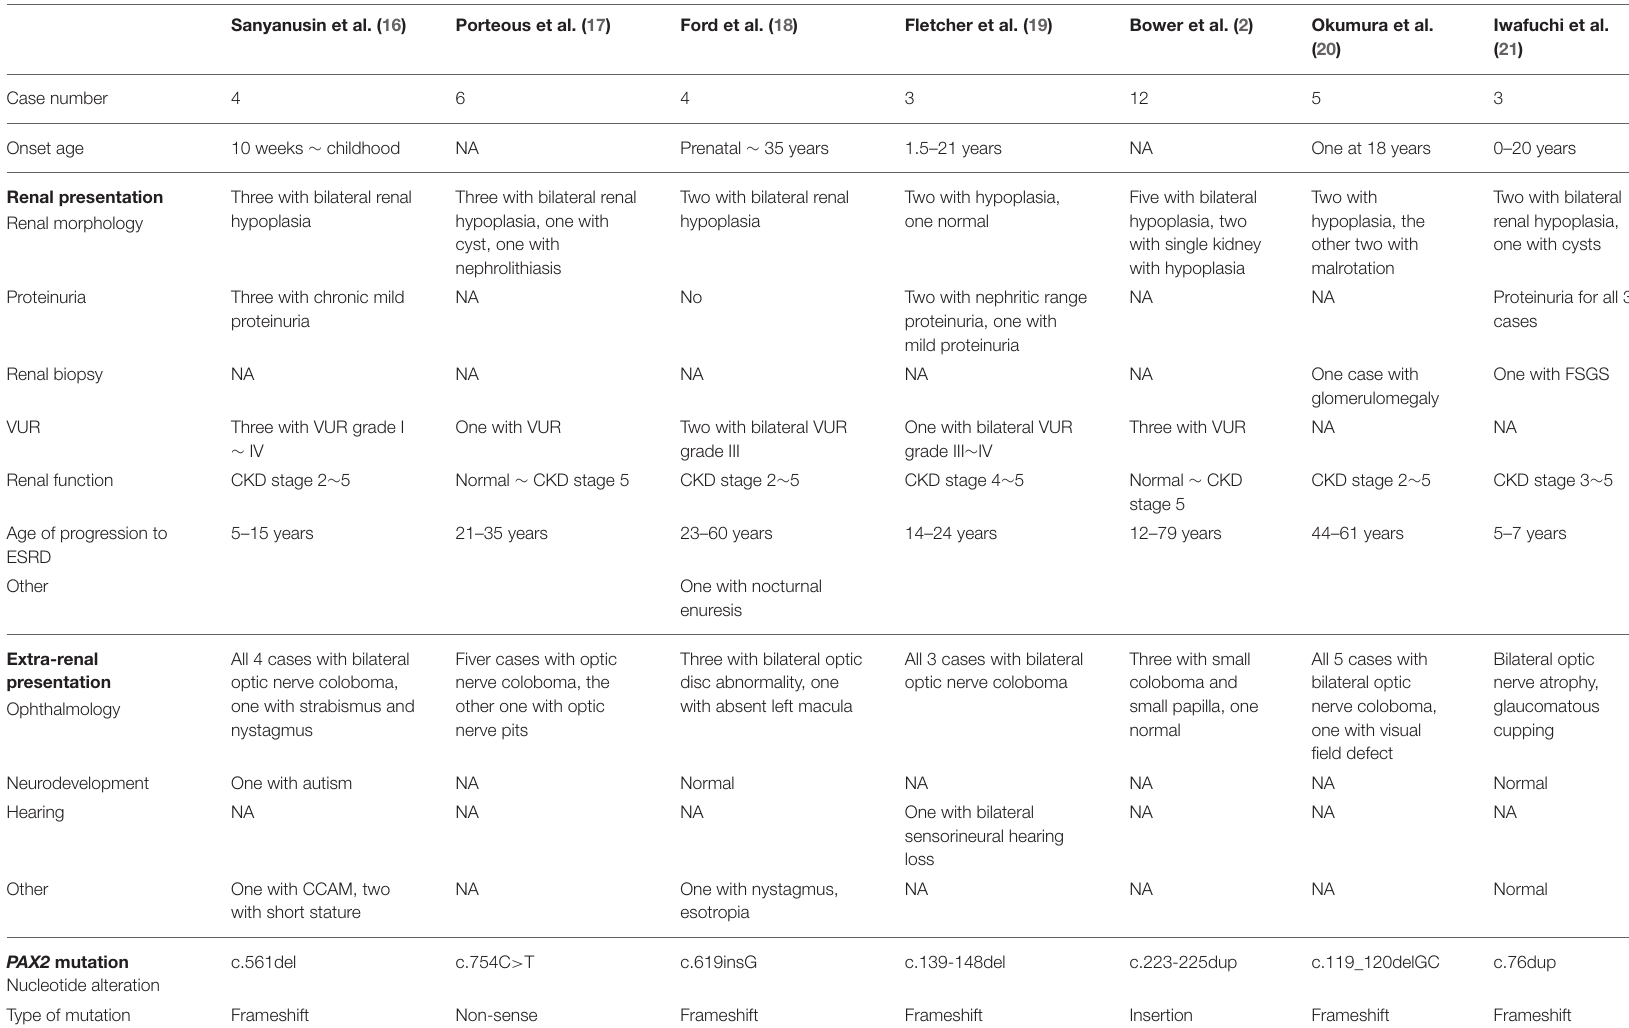
TABLE 3 | Reported familial cases of PAX2